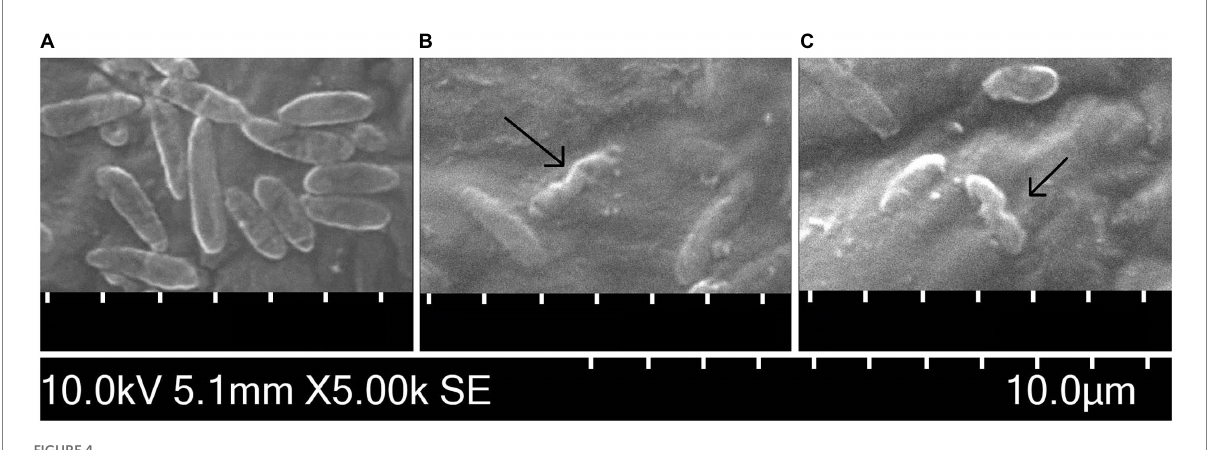
TABLE 8 Seed contamination index [%] for Xanthomonas campestris pv. campestris (Xcc) infection, germination of treated seeds [%] and quantification of Xcc in germinated plants.